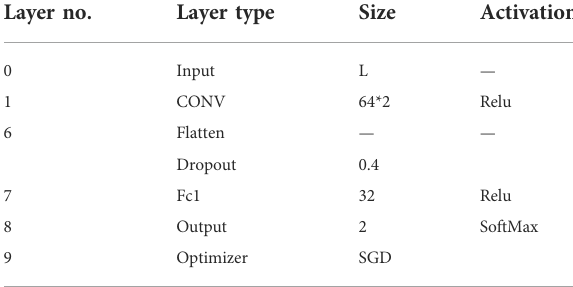
TABLE 1 Architecture and hyperparameter settings for 1D-CNN. The size column describes the kernel size of the convolutional layer, the size of the largest pooling layer, and the fully connected layer. Layer